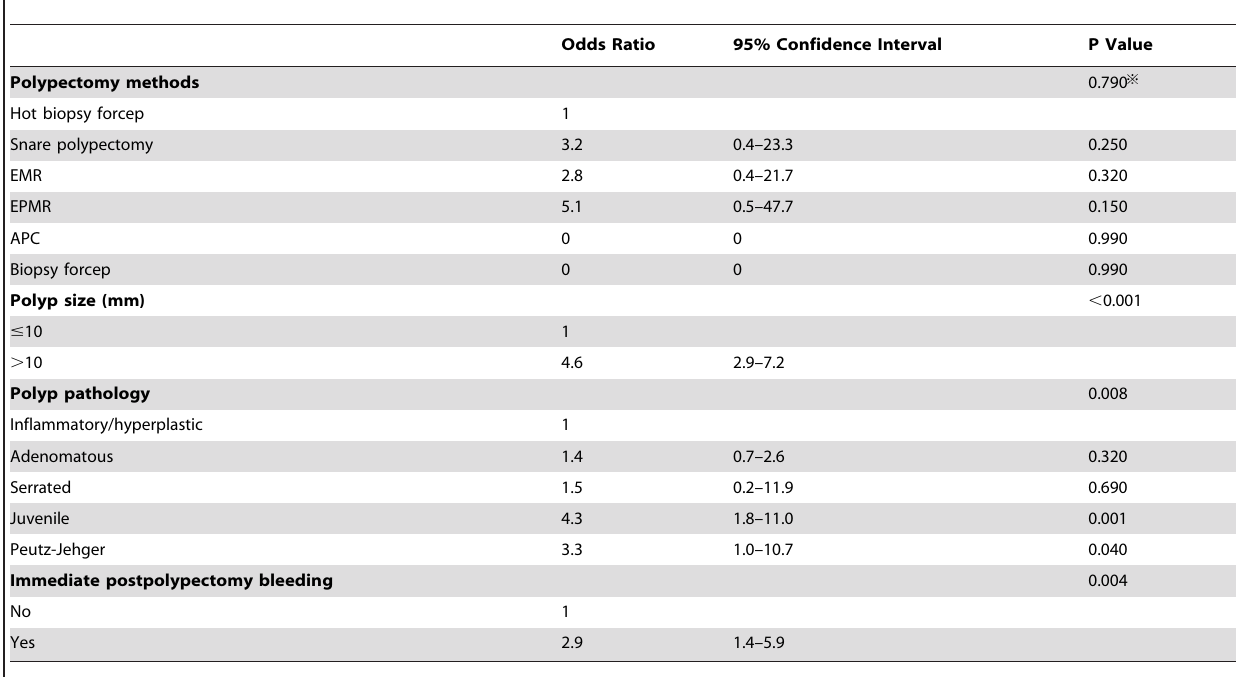
Table 3. Multivariate analysis of risk factors for delayed colonic postpolypectomy hemorrhage.